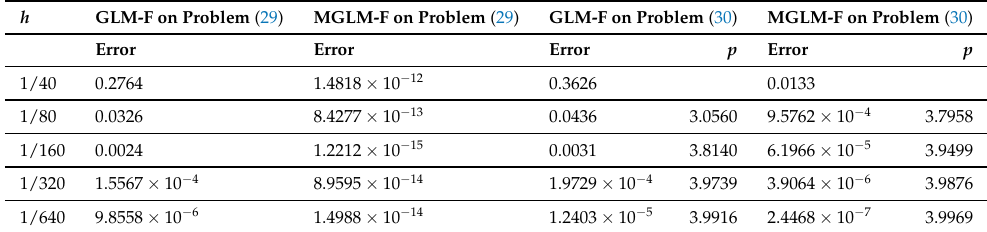
Table 2. Absolute errors (in the final step point) and effective orders of convergence. Absolute errors in the final step point and experimental orders of convergence with ω =